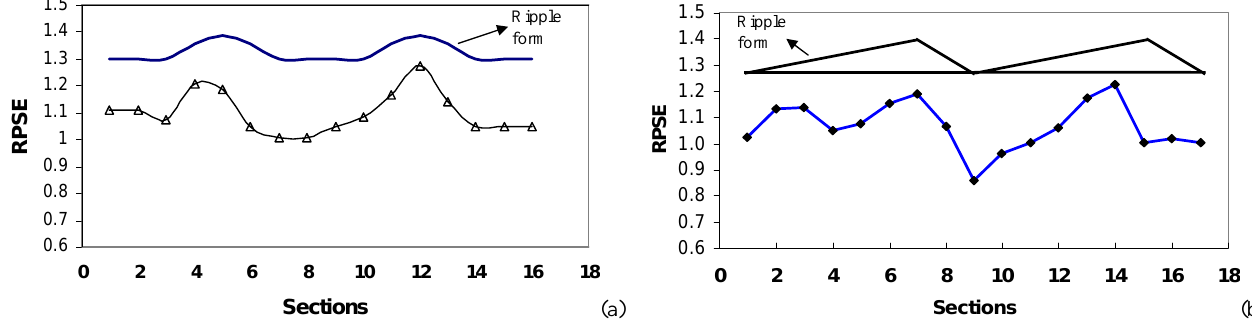
Fig. 8. The ratio of phase probability of sweep to ejection events (RPSE) over ripples (a) the sinusoidal ripple form; (b) the triangular ripple form.